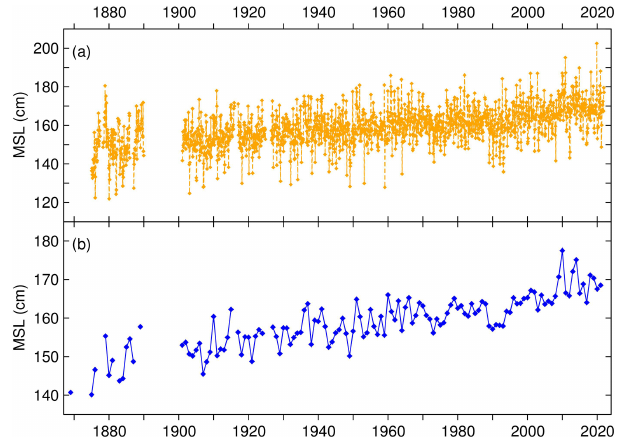
Figure 8. (a) Monthly MSL and (b) annual MSL. The data are ex- pressed in centimetres relative to the TG Zero (ZIT; see Fig. 5). The labels on the abscissa axis in panel (a) refer to the beginning of the